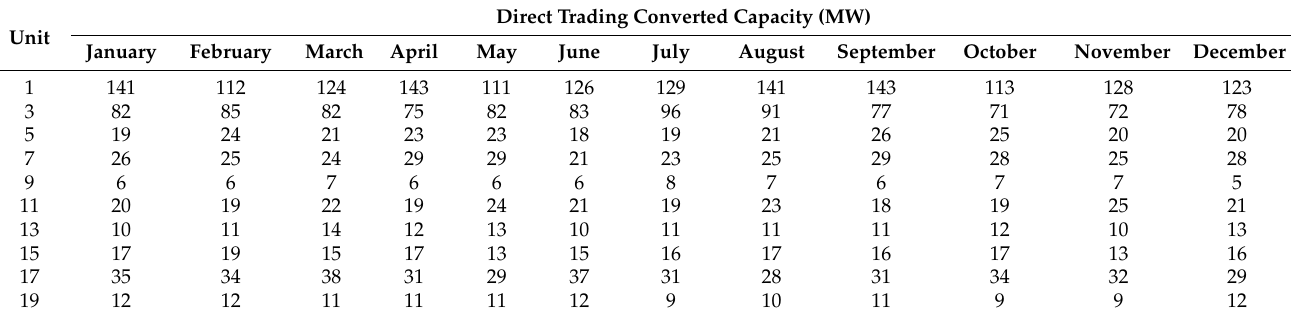
Table A5. Market electricity conversion capacity for each unit.